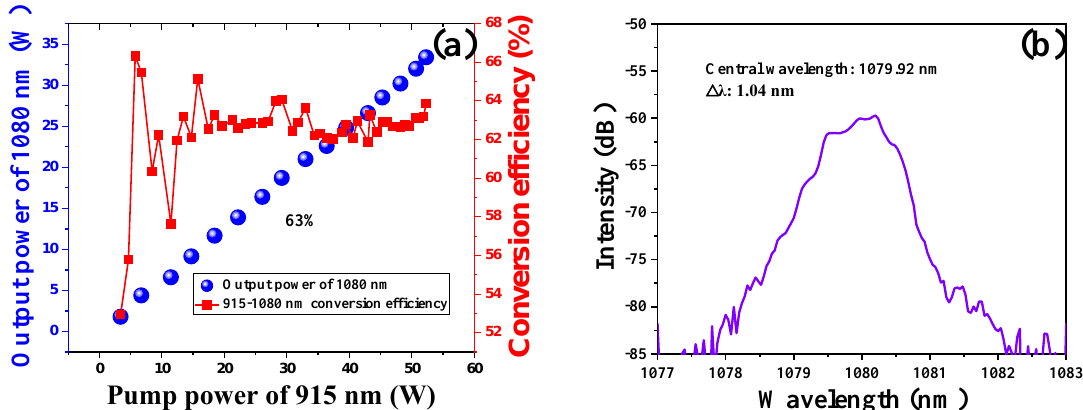
Figure 2. ( a ) Output power and conversion efficiency of the 1080-nanometer laser. ( b ) The emission optical spectrum of the 1080-nanometer laser.